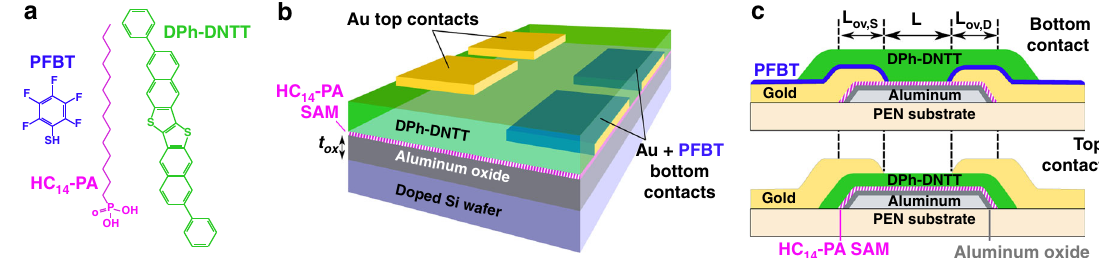
Fig. 1 Organic thin- fi lm transistors fabricated for this study. a Chemical structures of penta fl uorobenzenethiol (PFBT) used to treat the surface of the gold bottom contacts, of n -tetradecylphosphonic acid used for the gate-dielectric self-assembled monolayer (SAM), and of the organic semiconductor 2,9- diphenyl-dinaphtho-[2,3-b:2 ’ ,3 ’ -f]thieno[3,2-b]thiophene (DPh-DNTT). b Schematic cross-section of bottom-contact and top-contact organic TFTs fabricated on silicon substrates to study the relation between the gate-oxide thickness and the contact resistance. c Schematic cross-section of bottom- contact and top-contact organic TFTs fabricated on PEN substrates to evaluate the contact resistance and the dynamic performance of TFTs and circuits on